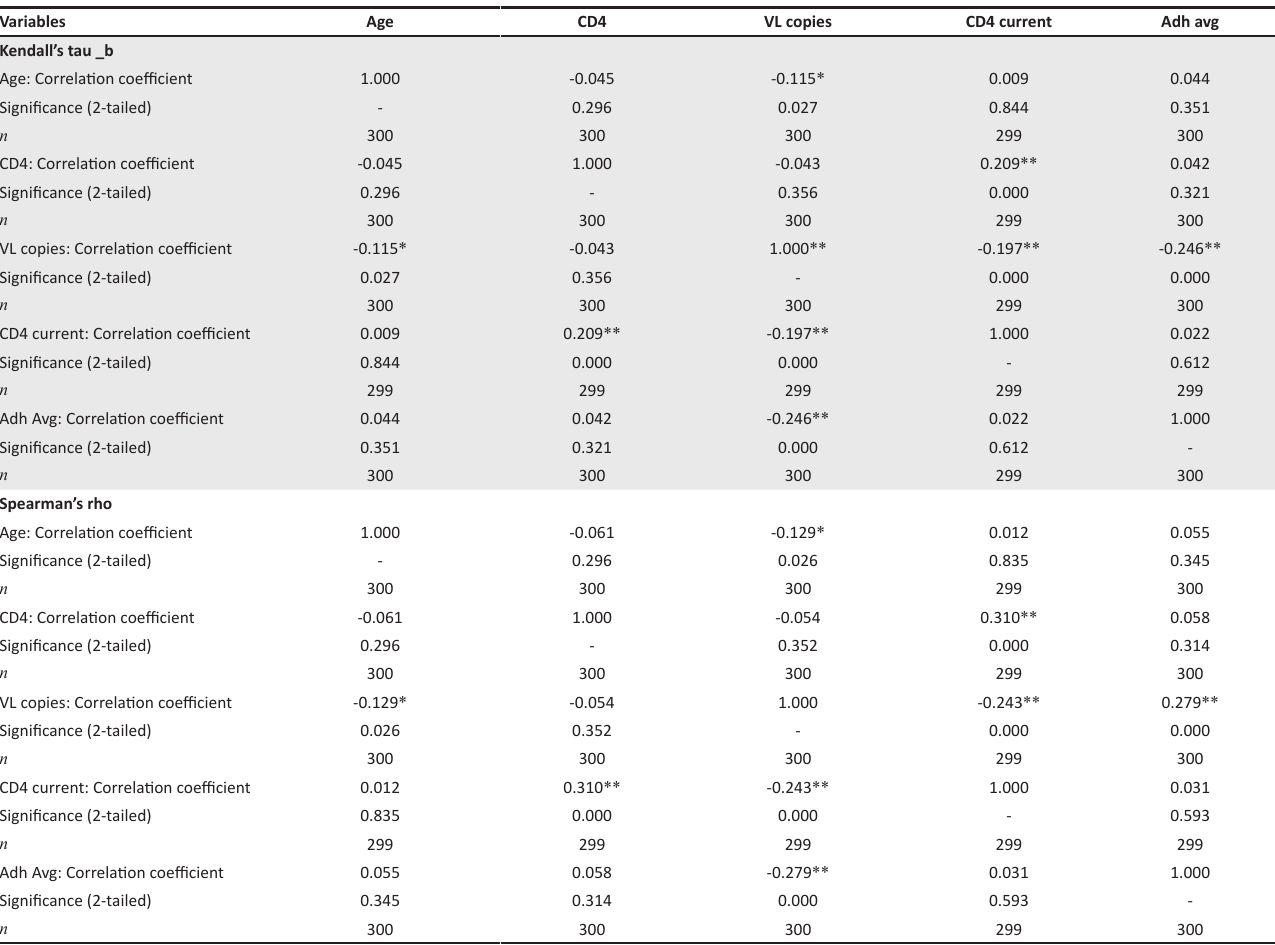
TABLE 3: Correlations between selected factors and